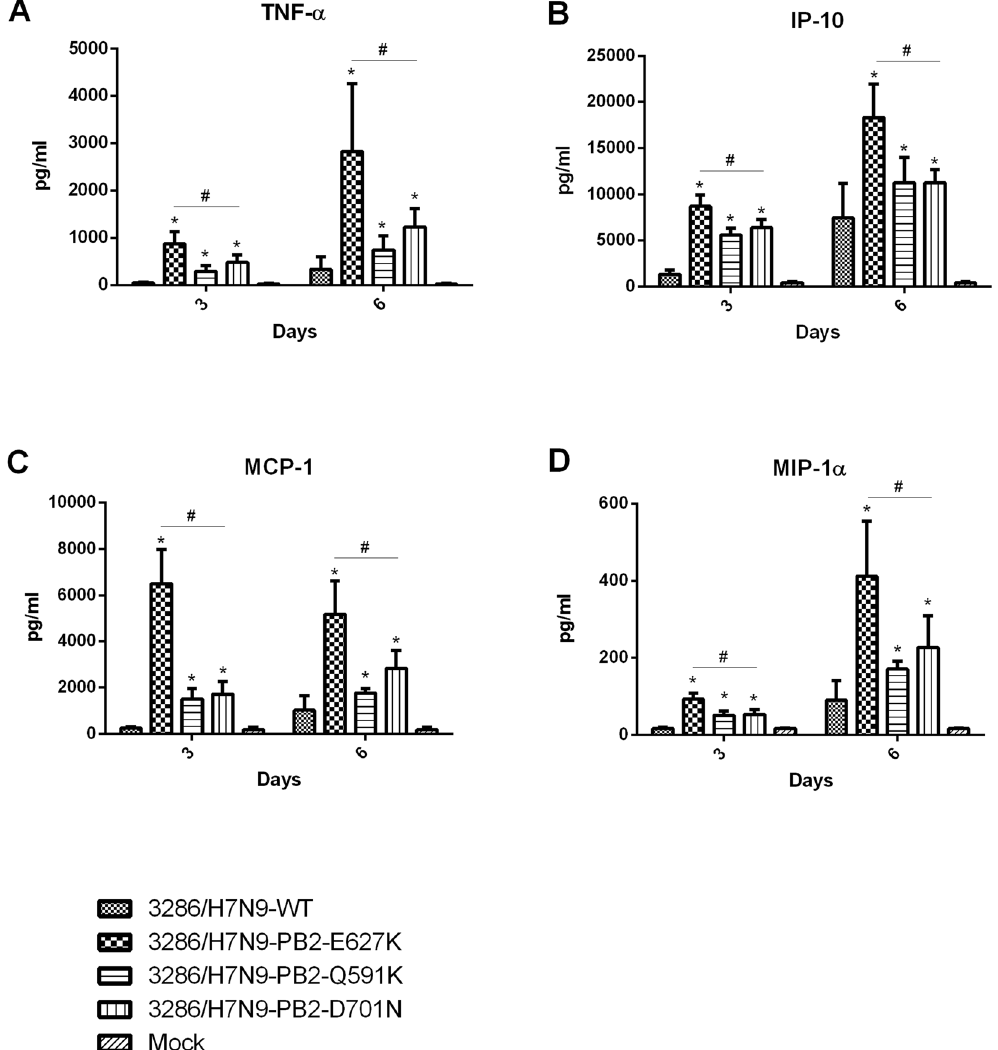
Figure 6. Cytokine responses in the lungs of mice infected with duck 3286/H7N9 and its PB2 mutants. Cytokine levels ( A ) TNF- α ( B ) IP-10 ( C ) MCP-1 ( D ) MIP-1 α from virus infected lungs (n = 6 mice per virus group, days 3, 6 post-inoculation) were measured individually by the FlowCytomi x system. Results from each time point are expressed as mean ± SD of six infected mice from two independent experiments. * The values were statistically compared with the wild type 3286/H7N9 using the two tailed, non-paired t-test. p < 0.05. # The values were statistically compared between the 3286/H7N9-PB2-E627K and other PB2 mutants using the two tailed, non-paired t-test. p <